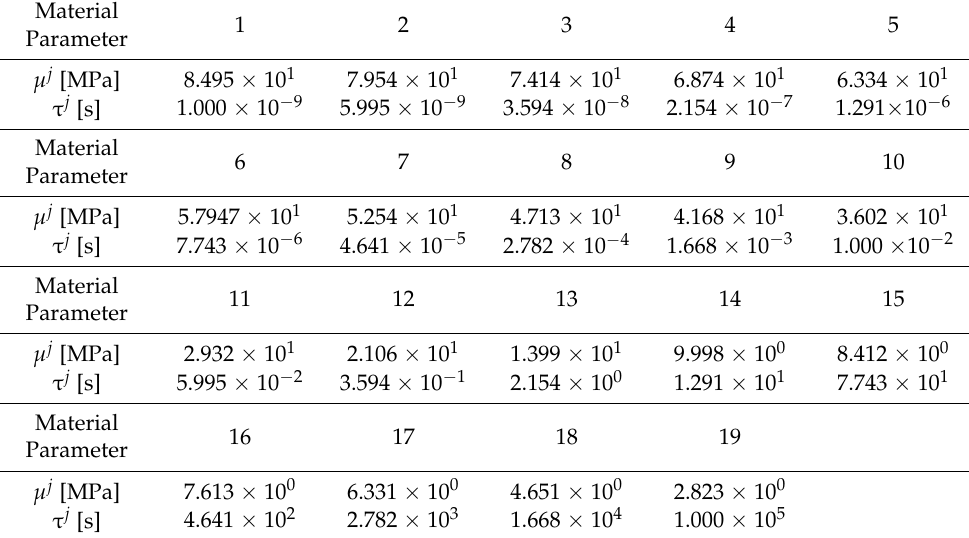
Table 2. Generalized Maxwell model relaxation times τ m , j and associated shear moduli µ j m consider- ing thermo-rheological simplicity for